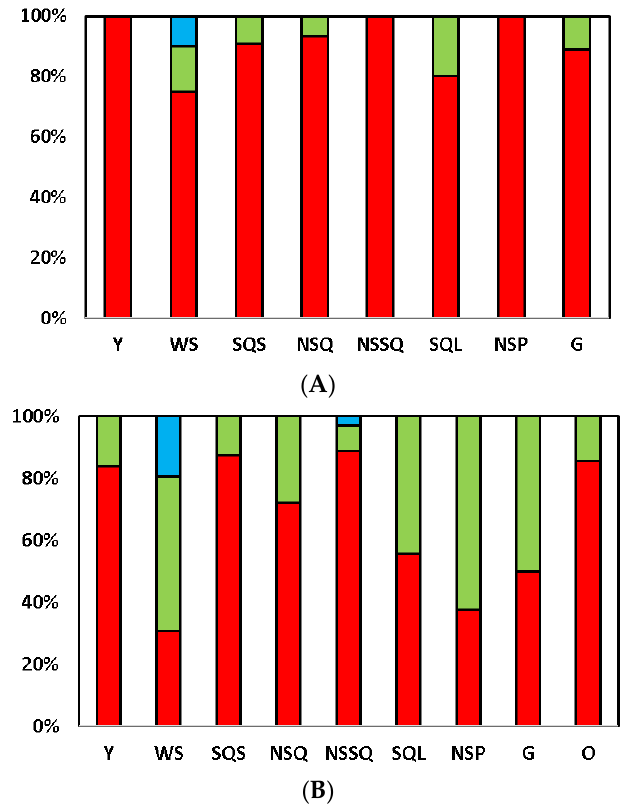
Table 3. Heterogeneity statistics and publication bias based on Begg and Mazumdar rank correla- tion for the meta-analyses conducted to test the effect of insect pollination on yield parameters in self-compatible (SC) and self-incompatible (SI) Brassicaceae. The yield parameters included in the meta-analysis were seed yield measured as seed weight/(plant, area, or open flower) (Y); weight of seeds (WS); silique set (SQS); number of siliquae/(plant or area) (NSQ); and number of seeds/(silique or open flower) (NSSQ).